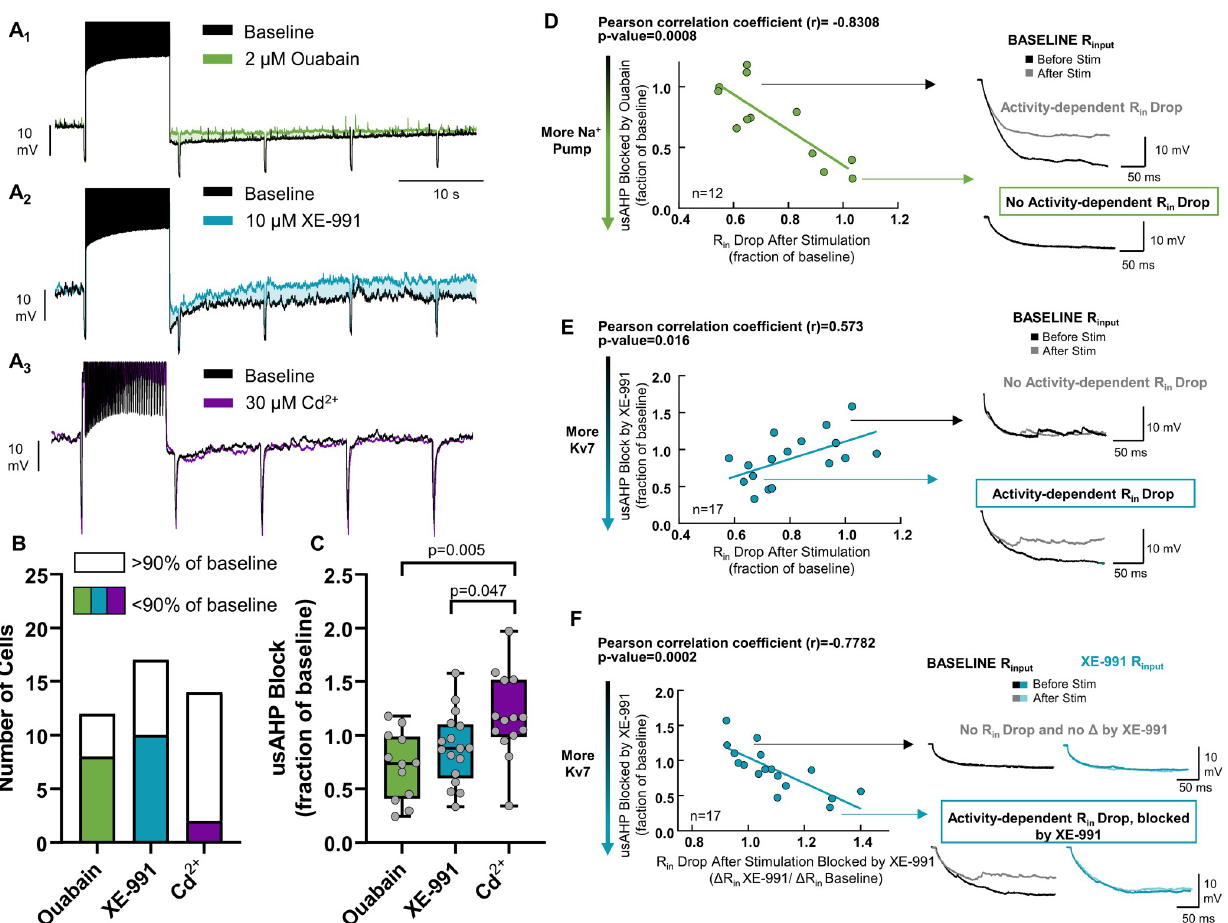
Fig 2. The dynamic Na + pump and Kv7 channels account for short-term feedback, with variable contributions from cell to cell. (A) Example recordings showing the effect of 2 μ M ouabain (dynamic Na + pump, n = 12 cells from N = 8 animals), 10 μ M XE-991 (Kv7, n = 17 cells from N = 5 animals), and 30 μ M Cd 2+ (Ca 2+ channels, n = 14 neurons from N = 4 animals) on the usAHP. (B) 2 μ M ouabain and 10 μ M XE-991 reduced the usAHP in most neurons, while 30 μ M Cd 2+ did not. The frequency of positive effects differed across drugs (Chi-square test; p = 0.012). (C) Mean changes in the usAHP by each drug (one-way ANOVA followed by Holm–Sidak Multiple Comparison test). (D) Correlation between sensitivity of the usAHP to ouabain and the drop in the first R in measurement following stimulation. Traces illustrate R in responses for each example neuron at different ends of the correlation. (E) Same as (D) but for XE-991. (F) Correlation between sensitivity of the usAHP and the drop in R in after block of Kv7 by XE-991. The x-axis shows the ratio of the change in R in during the usAHP after and before XE-991. Thus, greater values reflect a greater block of the R in drop following XE-991. Inset for (E) shows the ability for XE-911 to counter the drop in R in in neurons where XE-991 also reduced the usAHP. The data underlying this figure can be found in S1